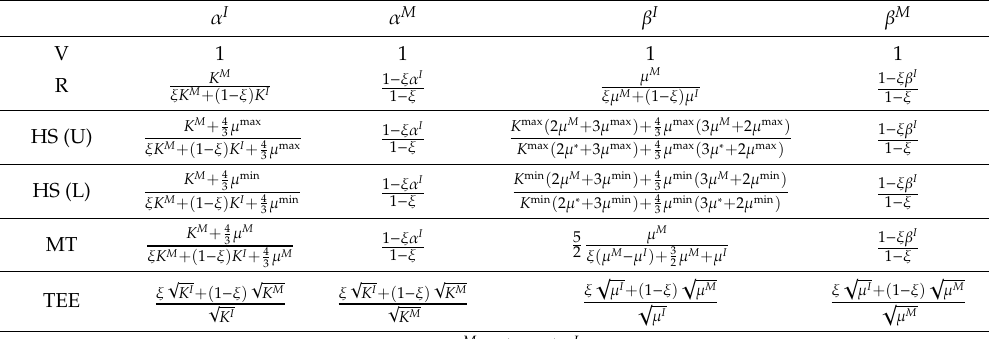
Table 3. Concentration factors for chosen di ff erent averaging schemes: (in MT spherical shape of inclusions was